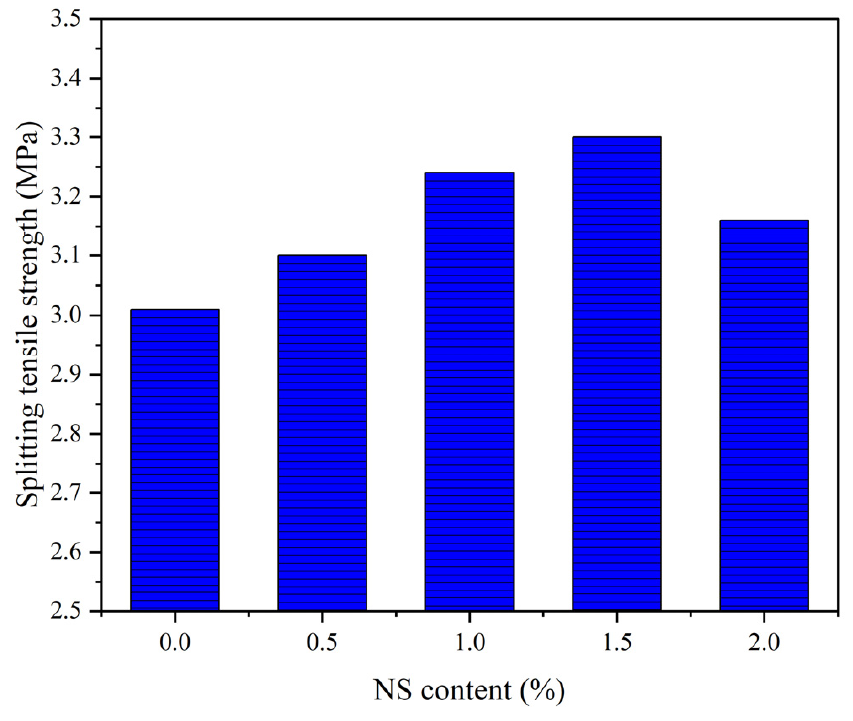
Figure 7. The splitting tensile strength of NS–GPC.